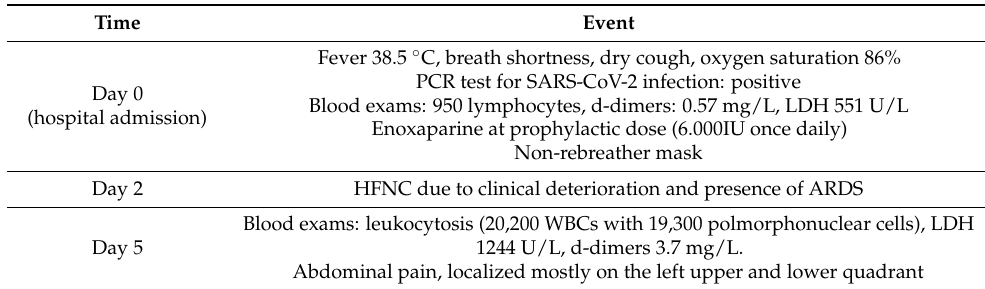
Table 1. Timeline of clinical sequelae of the